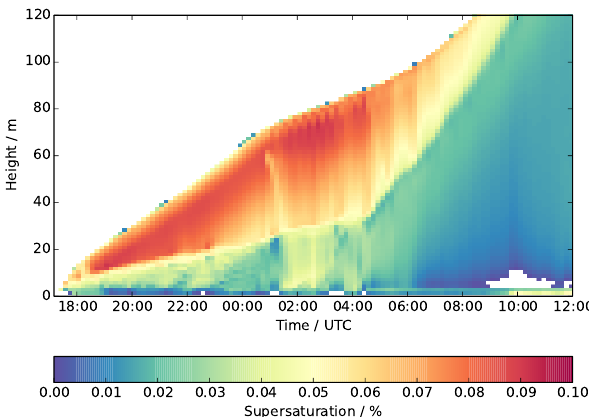
Figure 8. Time–height contour plot from the LES showing water vapour supersaturation with respect to the saturation vapour pres- sure over liquid water.